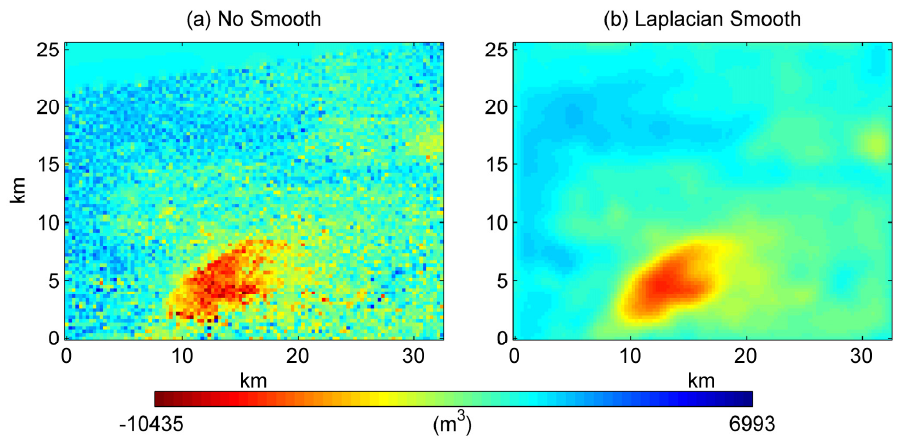
Figure 5. Mogi reservoir model: ( a ) no smooth applied; and ( b ) Laplacian smooth.